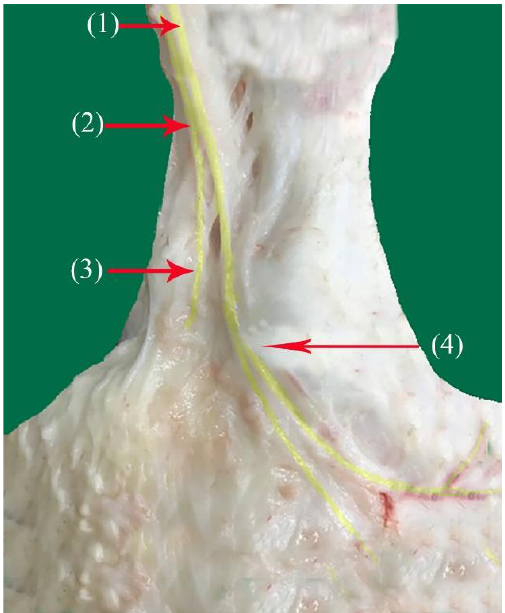
Figure 7. Nerve supply of the plantar surface of the phalanx in camels: (1) medial plantar nerve (common plantar digital nerve of the III digit); (2) interdigit branch of medial plantar nerve; (3) axial plantar proper digital nerve of the IV digit; (4) abaxial plantar proper digital nerve of the III digit.